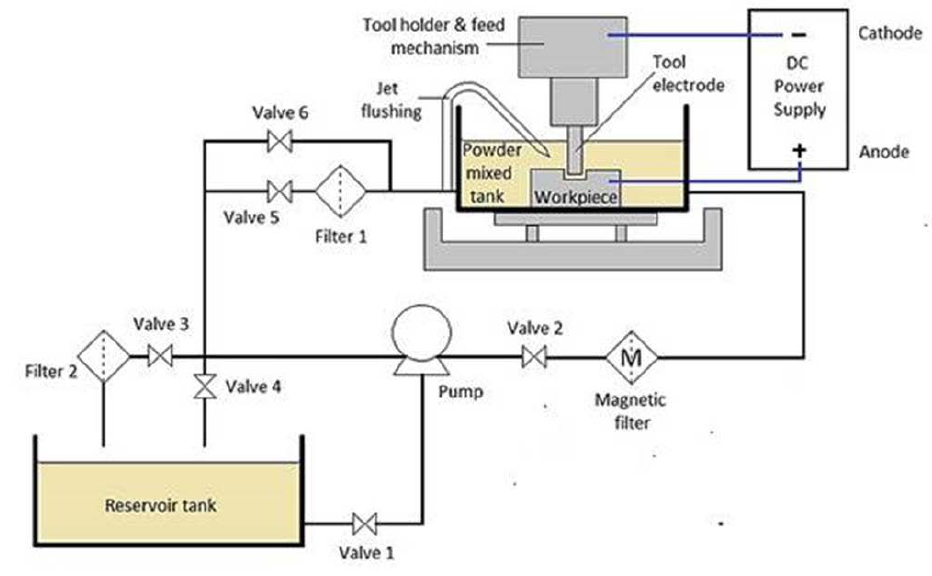
Figure 1: Schematic diagram